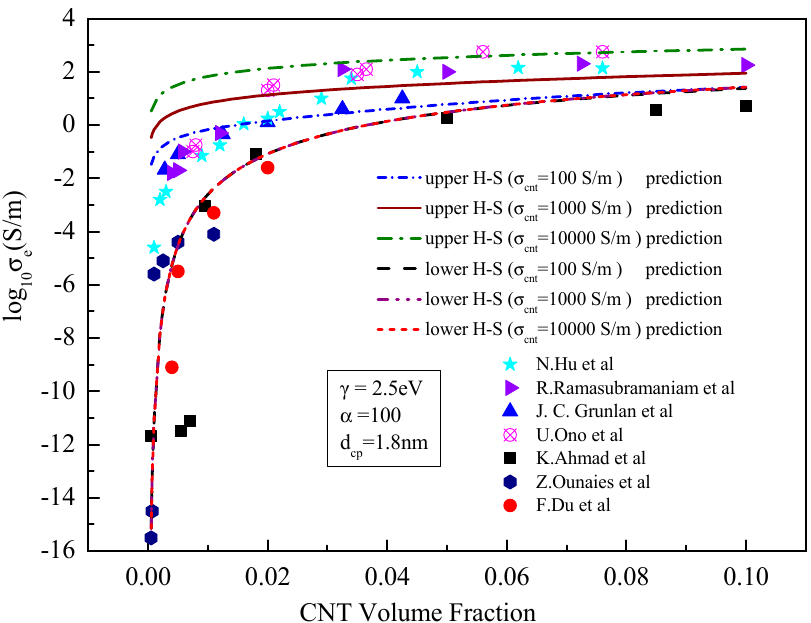
Figure 5. Comparison between the prediction results of the upper- and lower-bound models and existing experimental data [21,23–28] with different conductivity of the CNT.